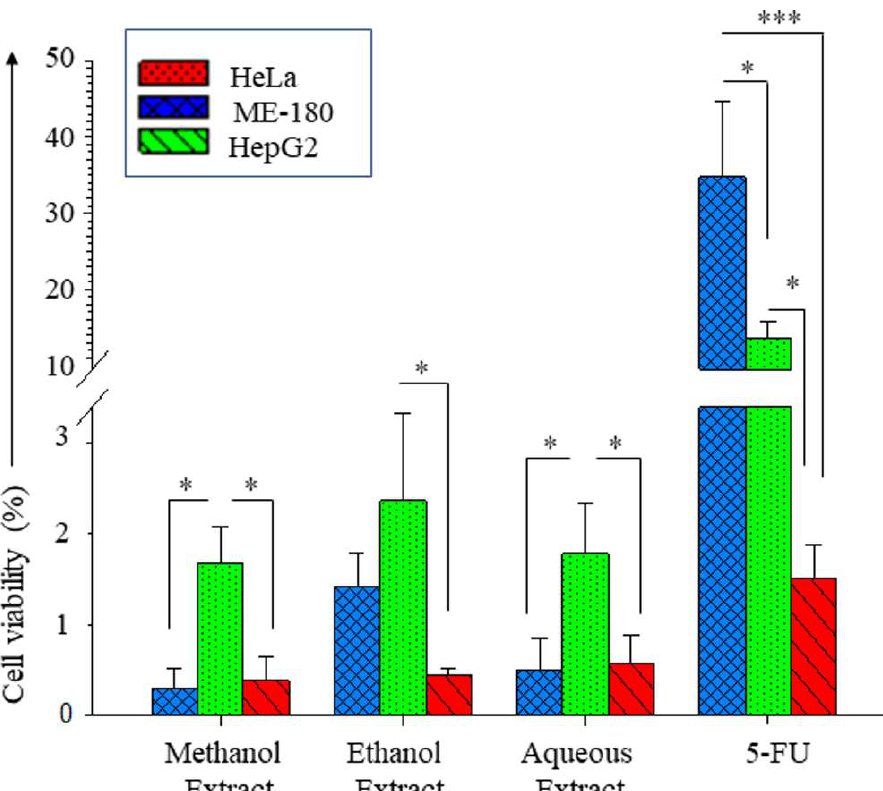
Figure 4. Comparison among the IC 50 of HeLa (blue), ME-180 (green) and HepG2 (red) cells upon treatment with R. cordifolia root extracts of methanol, ethanol, aqueous extract and 5-Flurouracil (5-FU). Results were expressed as the mean ± SD of three independent experiments, test of significance by ANOVA, wherein * and *** represent statistical significance of p < 0.05 and p < 0.001, respectively. Table 7. IC 50 of R. cordifolia extracts on viability of HeLa, ME-180 and HepG2 cells. Methanol Extract Ethanol Extract Aqueous 5-FU ( µ (mg/mL) (mg/mL) Extract (mg/mL)